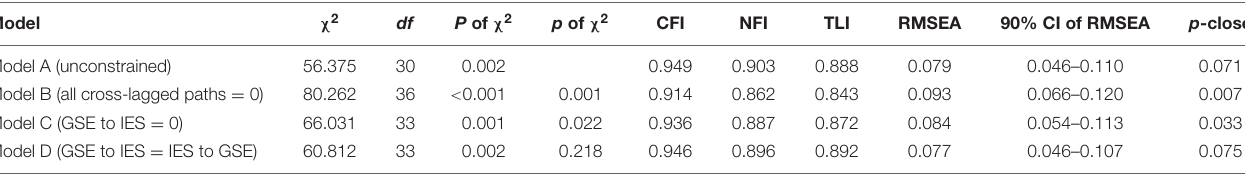
TABLE 3 | Model fits and model comparisons.